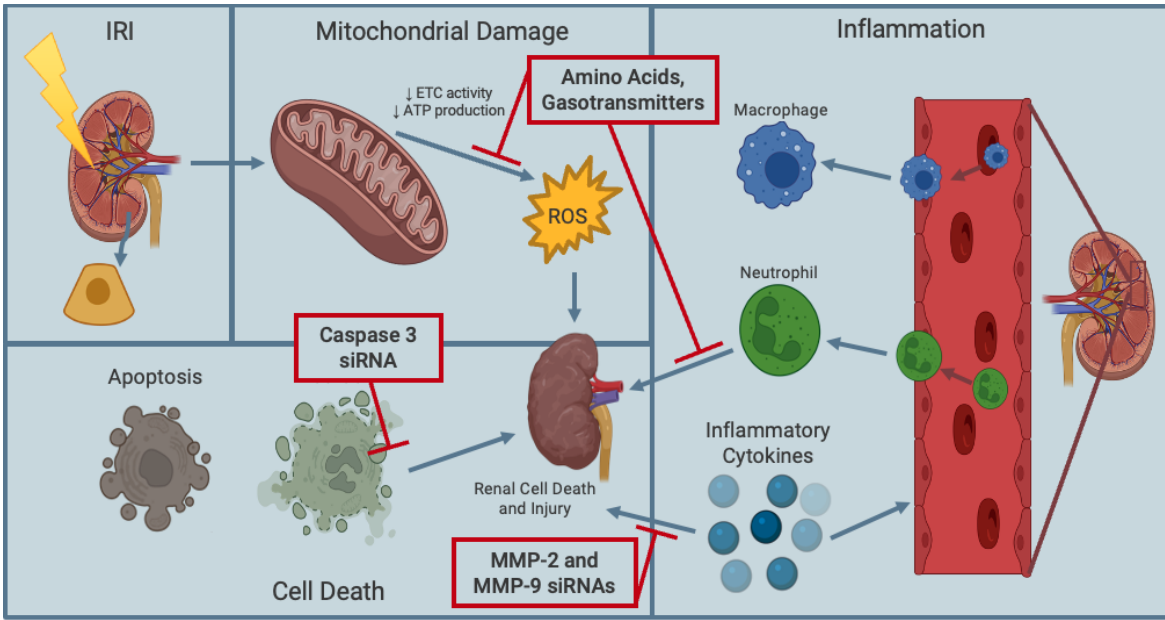
Figure 3. Schematic representation of effective supplementation of kidney preservation solution against renal IRI. Supplementing preservation solutions with amino acids or gasotransmitters can inhibit inflammatory and oxidative stress pathways and prevent the reduction in mitochondrial electron transport chain (ETC) activity and, thus, enhance adenosine triphosphate (ATP) produc- tion. Additionally, caspase-3 and MMP-2 and MMP-9 siRNAs can inhibit renal cellular death and inflammatory pathways, respectively, to protect renal grafts against ischemia-reperfusion injury and delayed graft function. Figure prepared with BioRender (biorender.com).